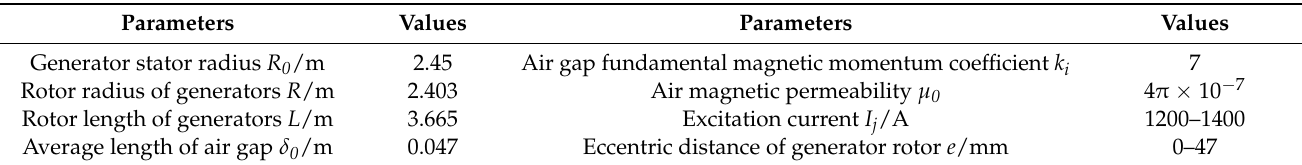
Table 1. Parameters of pumped storage plants.